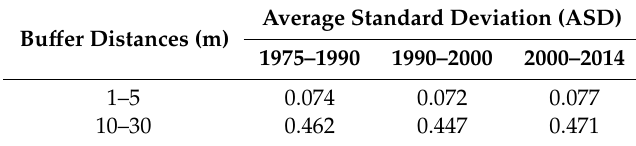
Table 1. Sensitivity analysis of LEI under di ff erent bu ff er distances in three periods. Average Standard Deviation Bu ff er Distances (m)